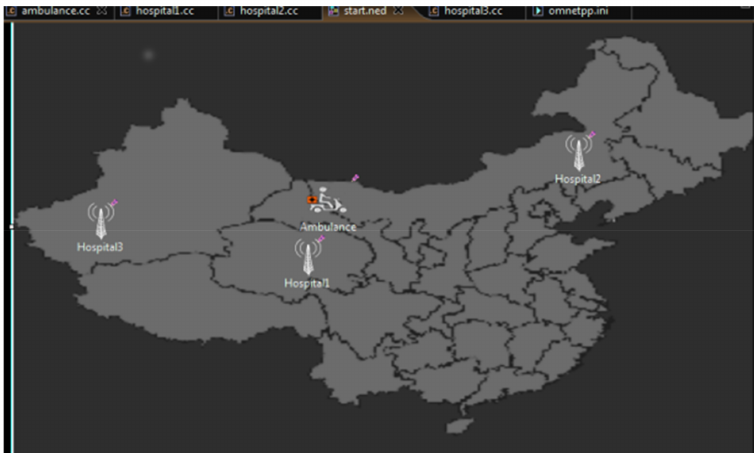
Figure 2. OMNeT++ simulation for telemedicine system.